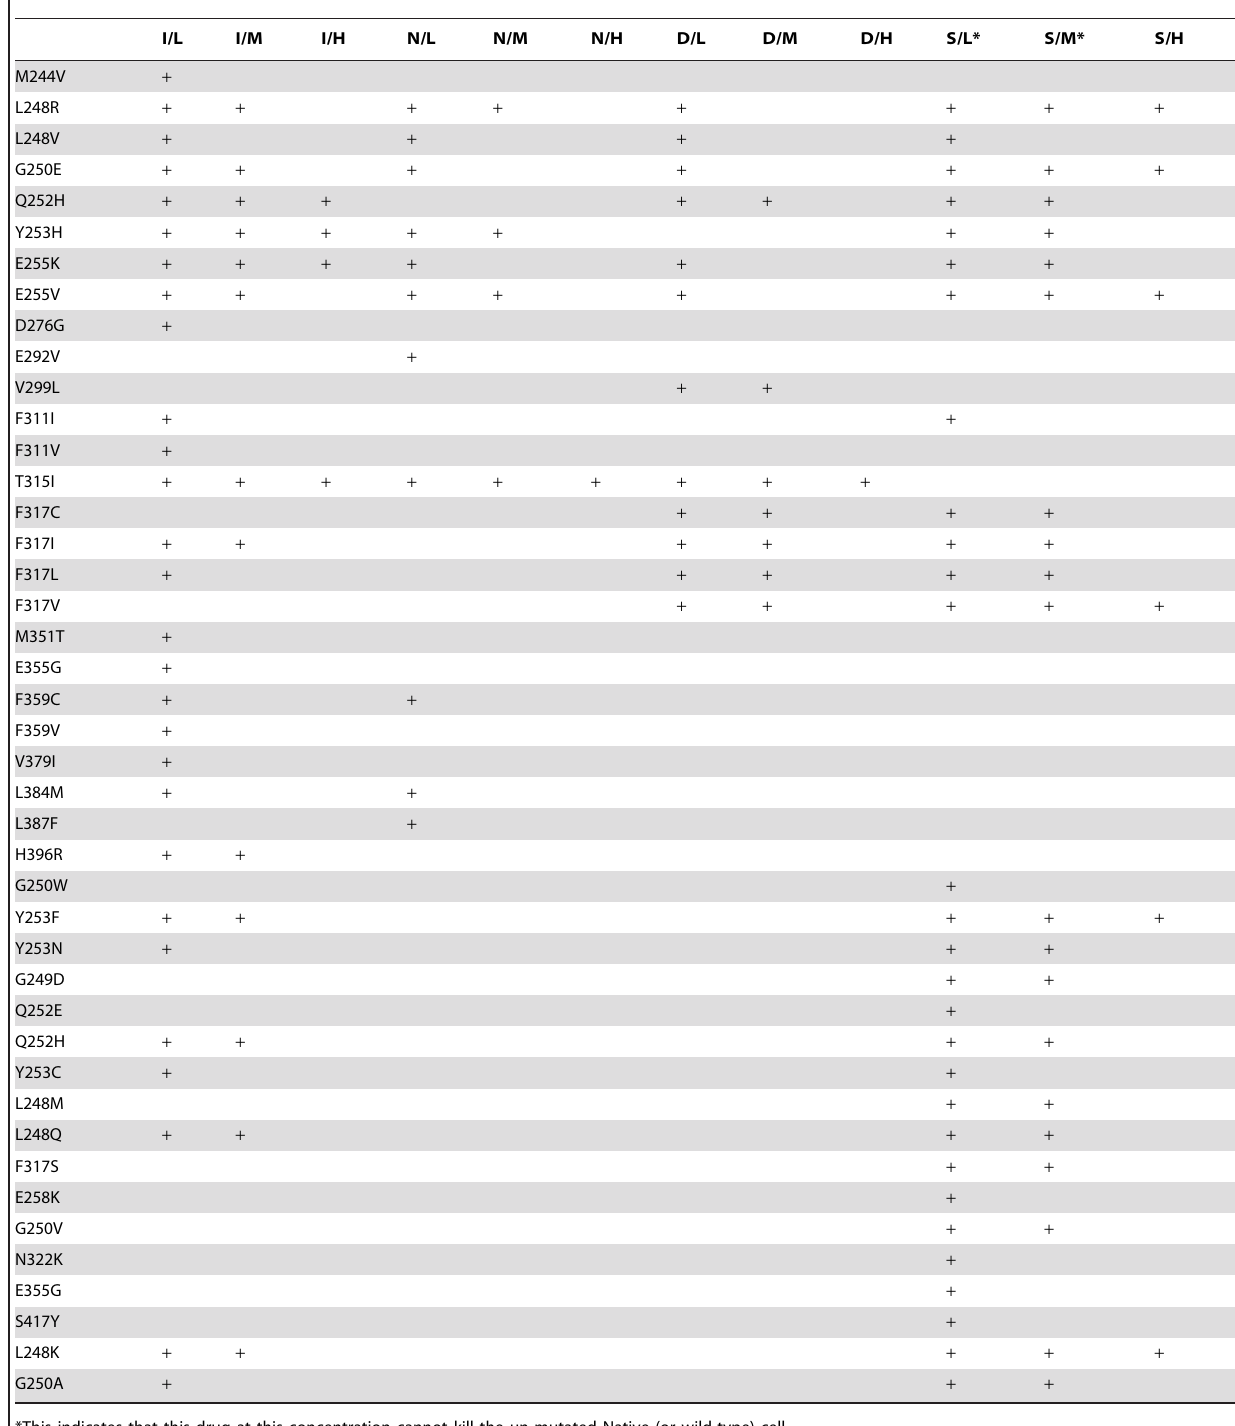
*This indicates that this drug at this concentration cannot kill the un-mutated Native (or wild-type) cell. The rows define the particular point-mutations and the columns define the inhibitors imatinib (I), nilotinib (N), dasatinib (D), and SGX70393 (S), with the indicated concentration (L, M, and H for Low, Medium and High, respectively). A ‘‘ + ’’ indicates that the mutant is resistant.